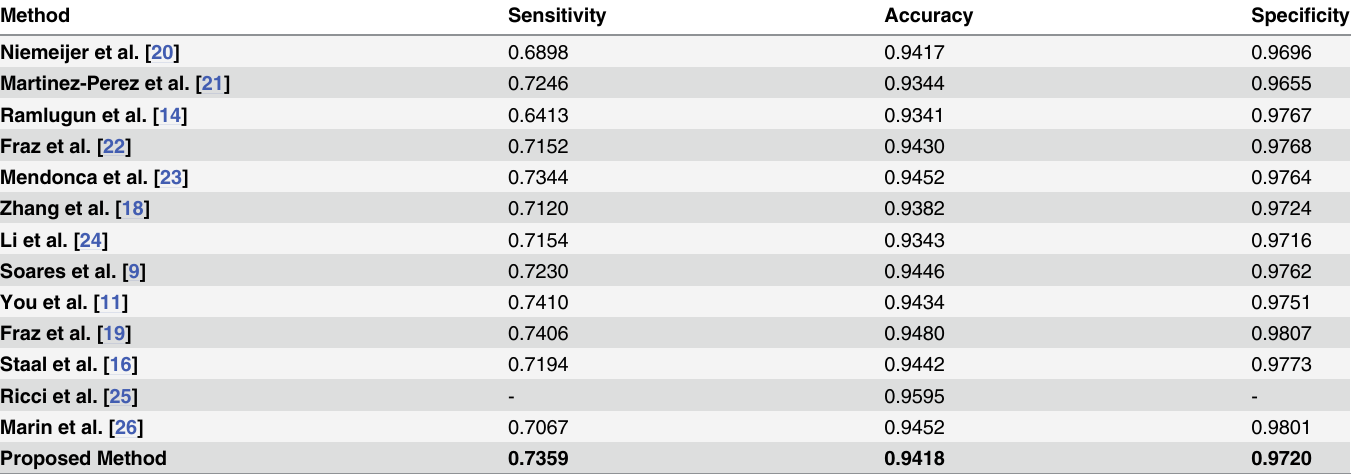
Table 1. Performance of multiple vessel segmentation methods using the DRIVE dataset.